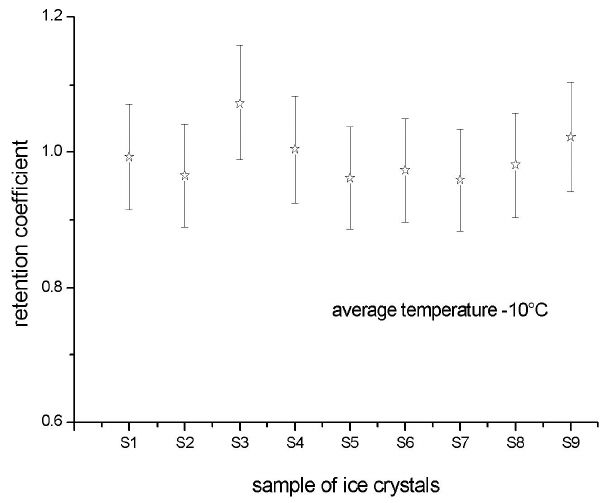
Fig. 4. Retention coefficient of HCl, determined with freely Figure 4. Retention coefficient of HCl, determined with freely floated ice crystals rimed with 2 floated ice crystals rimed with solution droplets with a concentra- solution droplets with a concentration of 90 ppmv. Several samples at an average air 3 tion of 90ppmv. Several samples at an average air temperature of − 10 ± 2 ◦ temperature of -10 ± 2 °C. 4